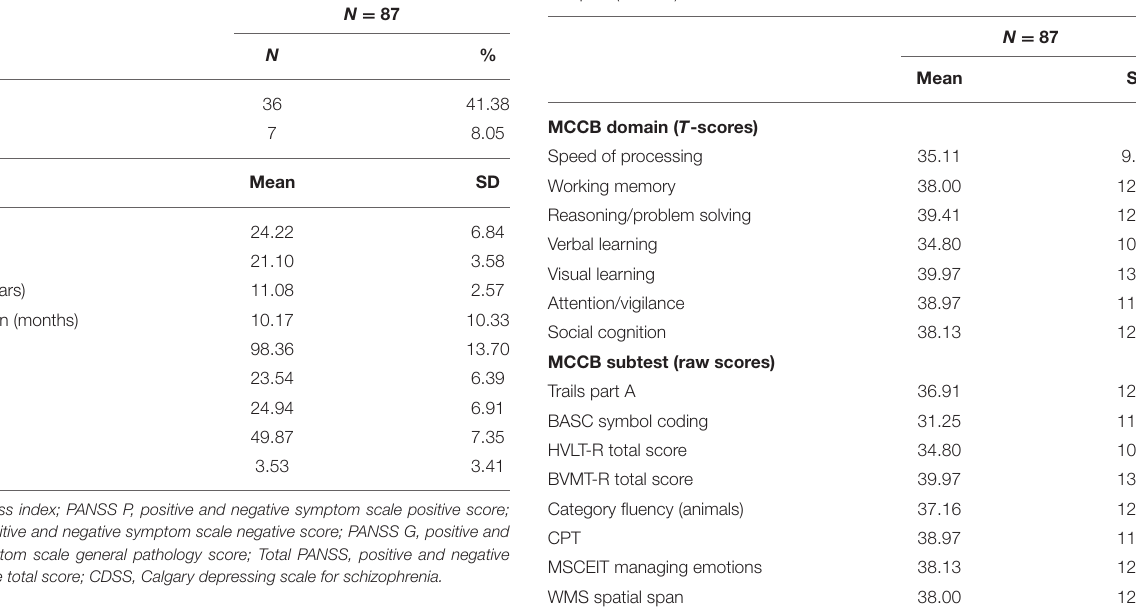
TABLE 1 | Demographic and clinical characteristics of full sample ( N = 87). TABLE 2 | MCCB standardized domain scores and raw subtest scores of full samples ( N =